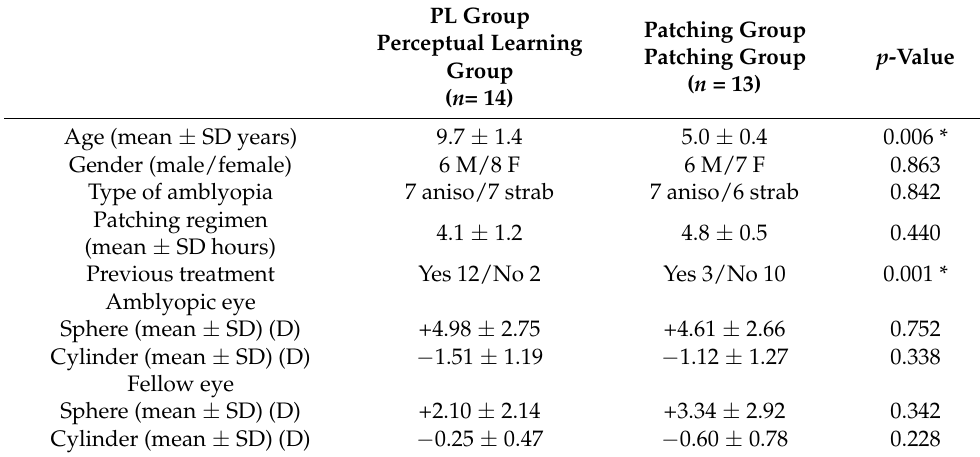
Table 1. Descriptive characteristics of the study sample.